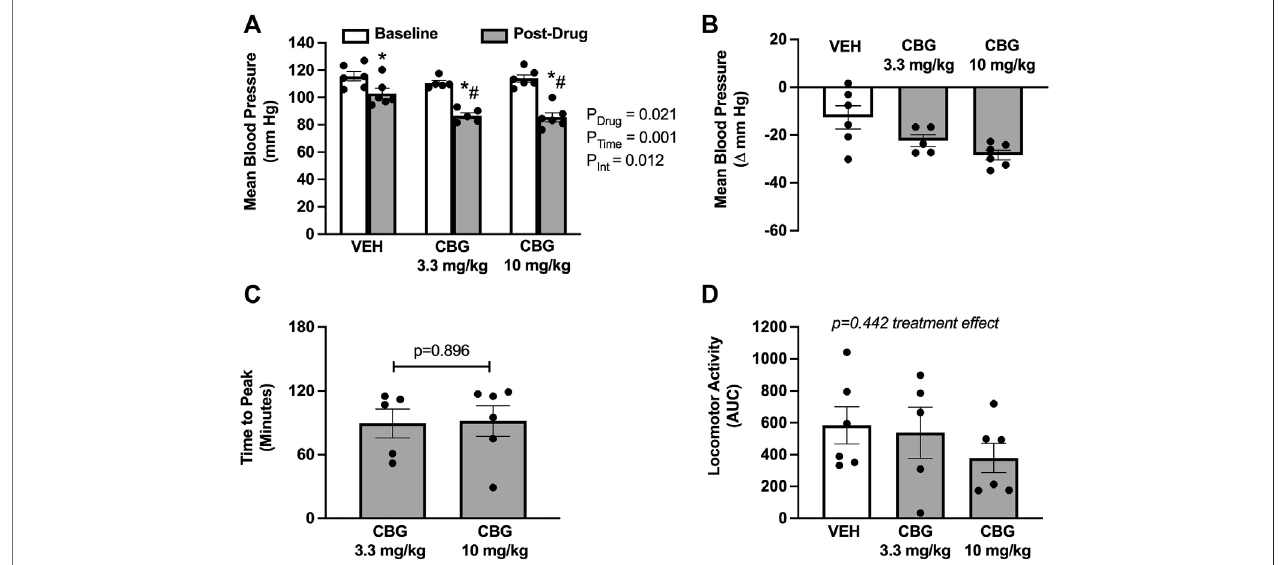
FIGURE 1 | Acute cannabigerol (CBG) administration decreases mean blood pressure. (A) CBG signi fi cantly lowered mean blood pressure when compared with vehicle (VEH) administration (P Drug = 0.021, P Time < 0.001, P Int = 0.019; mixed effects model; * p < 0.05 versus baseline and # p < 0.05 versus vehicle following post hoc Š ídák ’ s multiple comparisons test). (B) The magnitude of depressor effect of CBG was greater than VEH when shown as the peak change from baseline ( − 28 ± 2 at 10 mg/kg vs . − 22±2at3 mg/kg vs . − 12±5 mmHgvehicle). (C) ThepeakbloodpressureloweringeffectofCBGoccurredonaverageat~90 minforboth3.3and